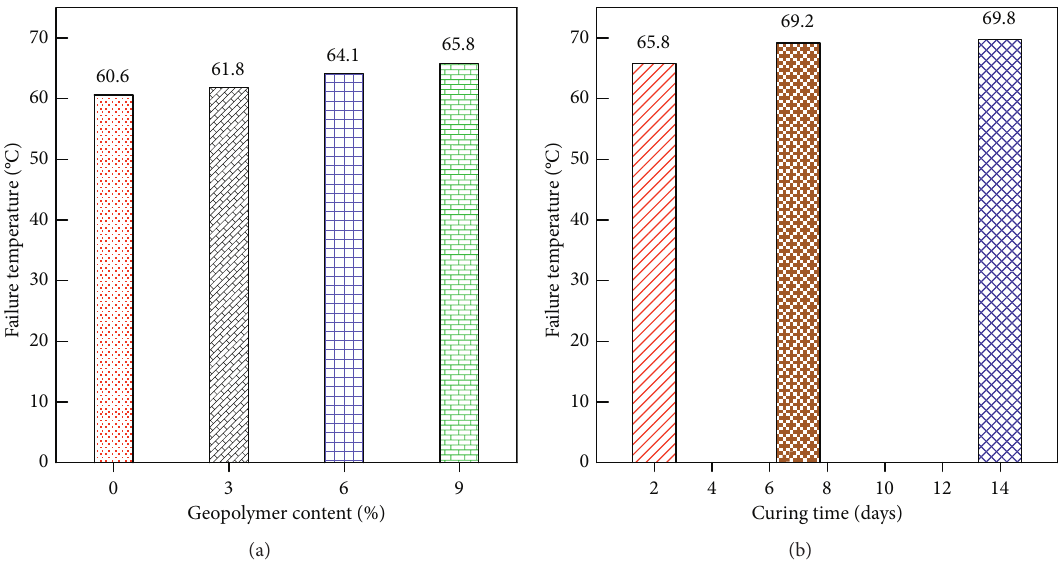
Figure 10: Effects of geopolymer on performance grading, (a) effects of geopolymer additives, (b) effects of curing time on 9% of geopolymer.